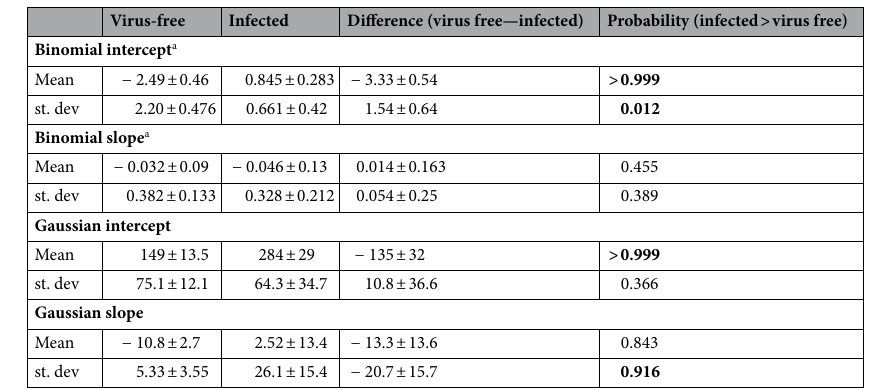
Table 1. Means and standard deviations of the posterior distributions describing the individual-level ‘random effects’ within the model used to estimate individual personalities. Each of the four parameters in the hurdle model with a direct biological interpretation (i.e. binomial intercept and slope = probability of emergence and change in emergence probability with each experience; gaussian intercept and slope = time of emergence and